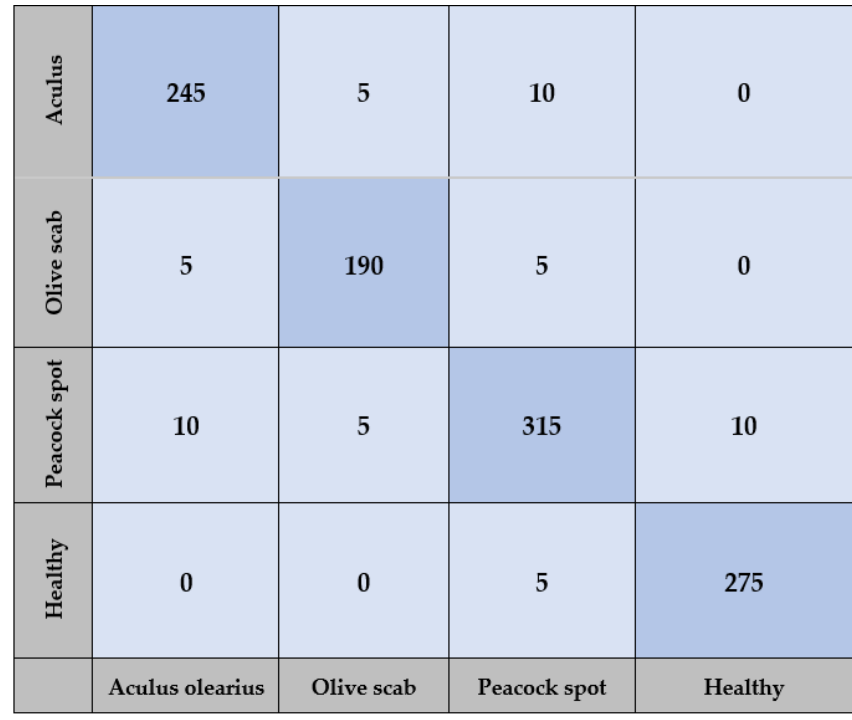
Figure 12. Confusion matrix for the MobileNet model.